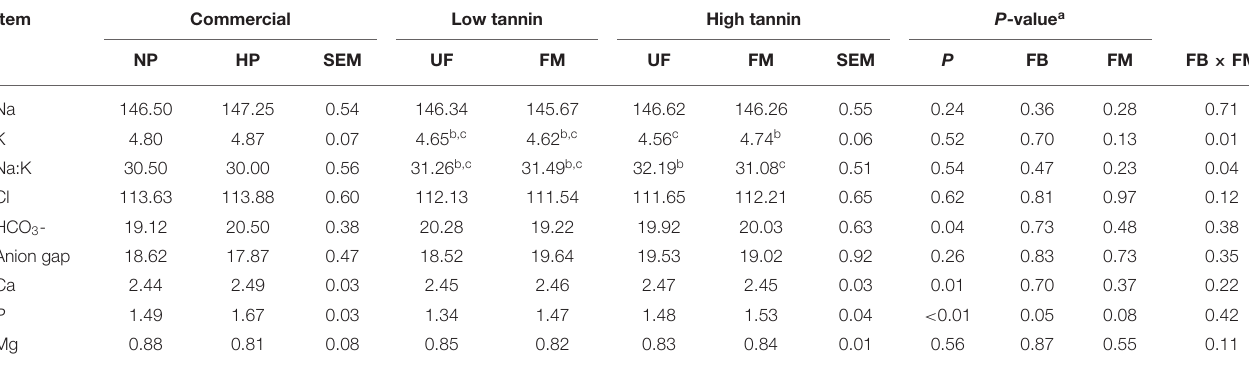
TABLE 4 | Blood electrolytes (mmol/L) of dogs fed diets formulated with either low or high tannin fava beans without (UF) or with (FM) fermentation, or normal (NP) vs. high (HP) protein commercial diets for 7 days each * . Item